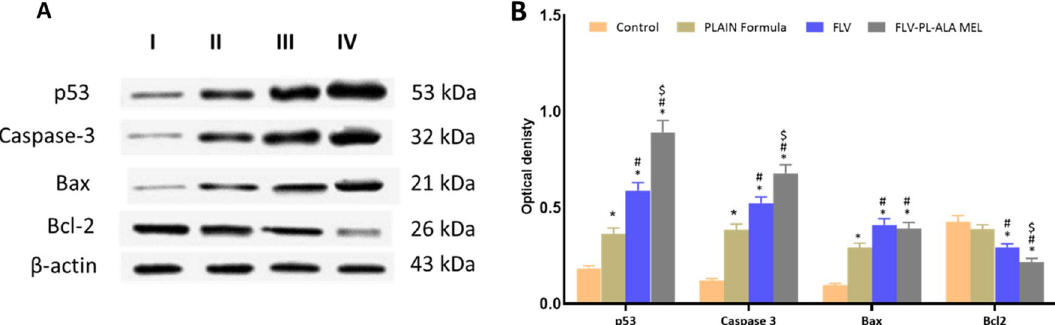
Figure 10. Bcl-2, Bax, Caspase 3, and p 53 proteins expression, Western blots ( A ) and histogram ( B ) for the groups (I) control (II) plain formula, (III) FLV and (IV) FLV-PL-ALA-MEL. *Significantly different versus control (p < 0.05). # Significantly different versus plain formula (p < 0.05). $ Significantly different versus FLV raw (P <